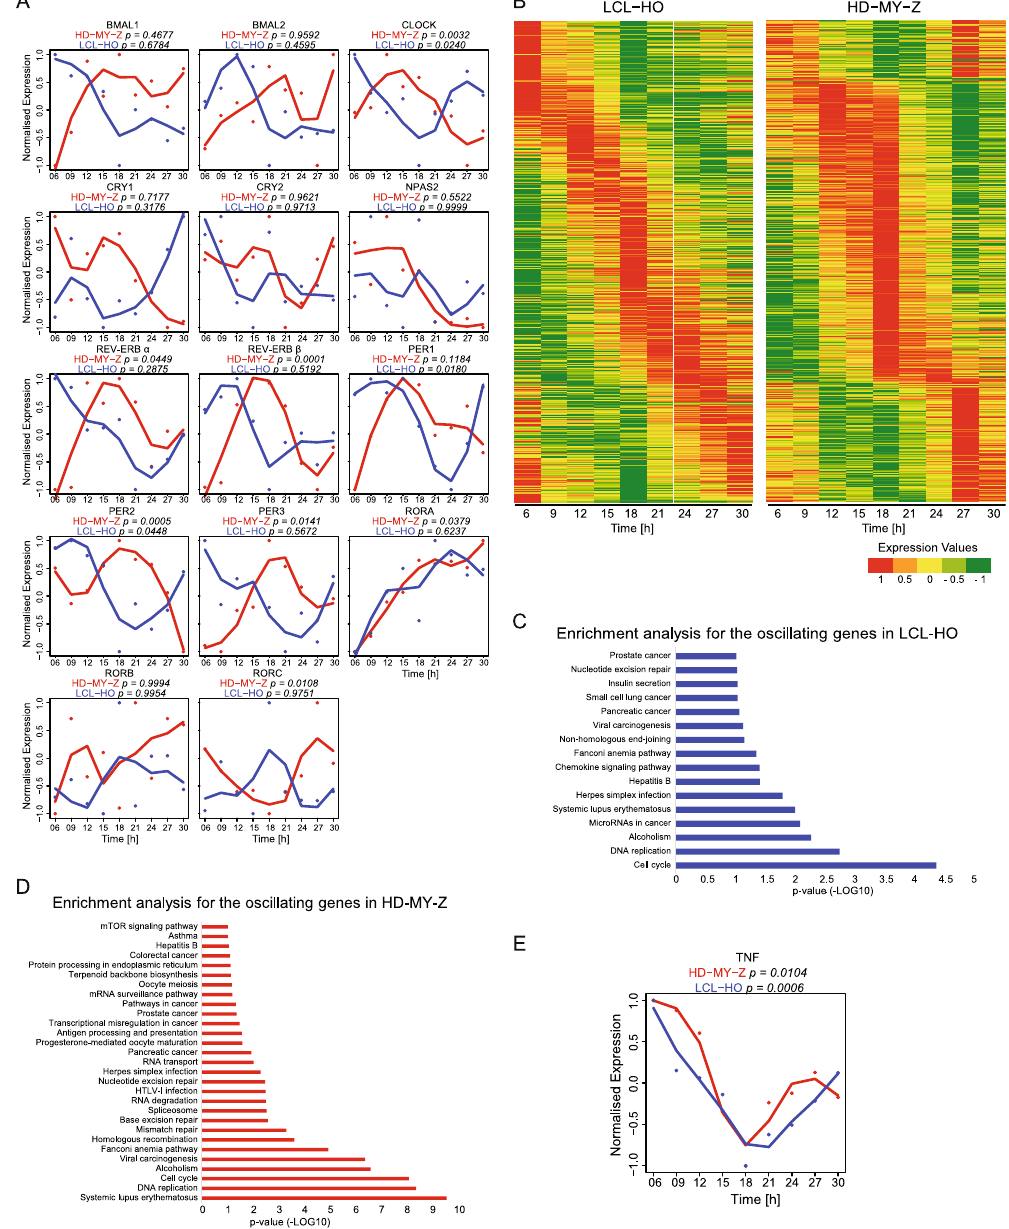
Figure 3. The genome-wide landscape of oscillating genes in LCL-HO and HD-MY-Z revealed cell-specific circadian regulation in HL. ( A ) Depicted are expression values for core-clock genes for LCL-HO (blue) and HD-MY-Z (red) retrieved from the time course array data. ( B ) Oscillating genes present in LCL-HO and the HL cell line HD-MY-Z, respectively, phase ordered and normalized to values between − 1 and 1. ( C , D ) Enrichment analysis (KEGG pathways) for the previously described genes in the different cell lines. ( E ) TNF relative gene expression retrieved from the array data in LCL-HO (p = 0.0006) and HD-MY-Z (p = 0.0104), respectively. ( A , E ) Based on the data from the time course HTA2.0 microarray experiments we performed an additional normalization in the range 1, − 1. The normalized data was used to fit a curve with Local Polynomial Regression Fitting. The genes were analysed with the MetaCycle R package for a period set to 21 to 27 hours. The combined Metacycle p-values are displayed for each